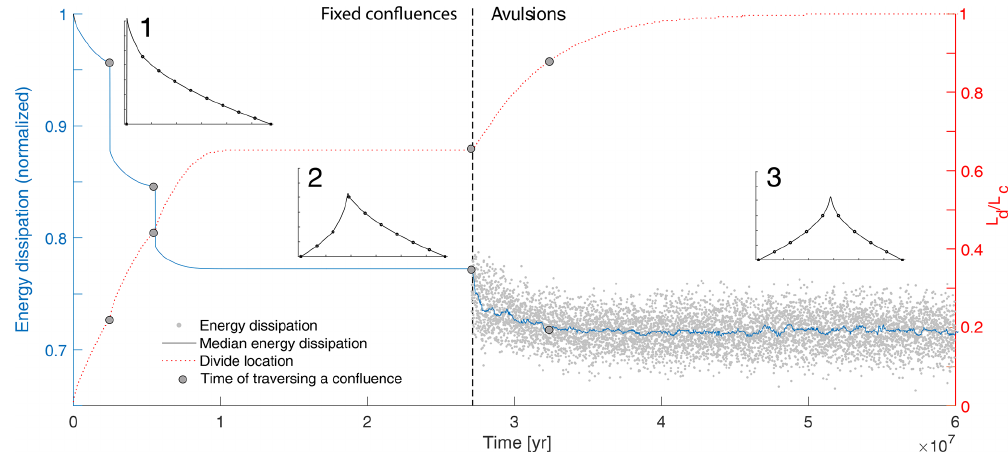
Figure 8. The influence of avulsions on energy dissipation and wind-gap location. Model run time is shown on the x axis, energy dissipation (normalized by its maximal value) on the left y axis, and wind-gap location relative to the center of the model domain (i.e., L d /L c , Fig. 5) on the right y axis. The plot shows the results of a fixed confluence simulation that produced a stable wind-gap position away from the center of the model domain at approximately 1 × 10 7 years. An avulsion simulation introduced at approximately 2.7 × 10 7 years perturbed this stable topography and triggered further divide migration to the center of the model domain. While avulsions can temporally increase the energy dissipation of the system, they lead to an abrupt decrease in energy dissipation as confluences (gray circles) are being traversed. Inset images 1–3 correspond to the topographic profiles in different stages in this experiment (similar to those in Fig. 5b) and show the initial topography (1), a stable asymmetric divide position attained with fixed confluence simulations (2), and a stable symmetric divide position attained with an avulsion simulation (3). Model parameters are given in Table 1. The calculation of energy dissipation, based on Sun et al. (1994a, b), is described in the